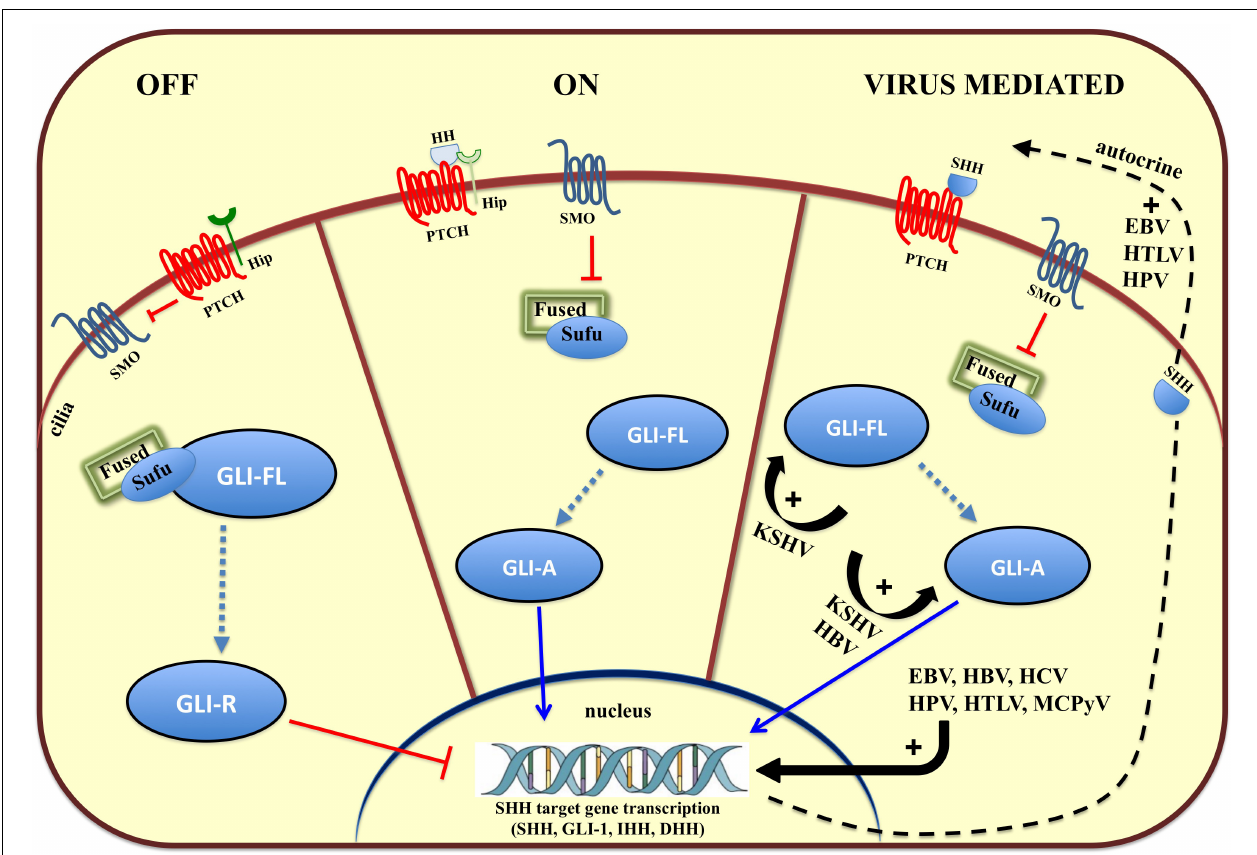
FIGURE 1 | Overview of the Hedgehog (HH) signaling pathway and modulation by oncoviruses. On the left, in the absence of HH ligands (SHH, IHH, and DHH), the HH receptor Patched (PTCH) keeps the pathway off (OFF) by inhibiting Smoothened (SMO), and keeping the glioma-associated oncogene (GLI) transcription factors in an inactive form (GLI-R). In the middle, binding of HH ligand to HH receptor, PTCH, turns the pathway on (ON), and inhibits its activity, relieving the repression of SMO, which converts full-length GLI (GLI-FL) into a transcriptional activator (GLI-A). In vertebrates, cilia are required for production of GLI-repressor (GLI-R) and/or GLI-activator (GLI-A). On the left, viruses hyperactivate HH signaling with multiple mechanisms (VIRUS MEDIATED). EBV, Epstein Barr Virus; HBV, Hepatitis B Virus; HCV, Hepatitis C Virus; HPV, Human Papilloma Virus, KSHV, Kaposi’s Sarcoma-associated Herpes Virus; MCPyV, Merkel Cell Polyoma